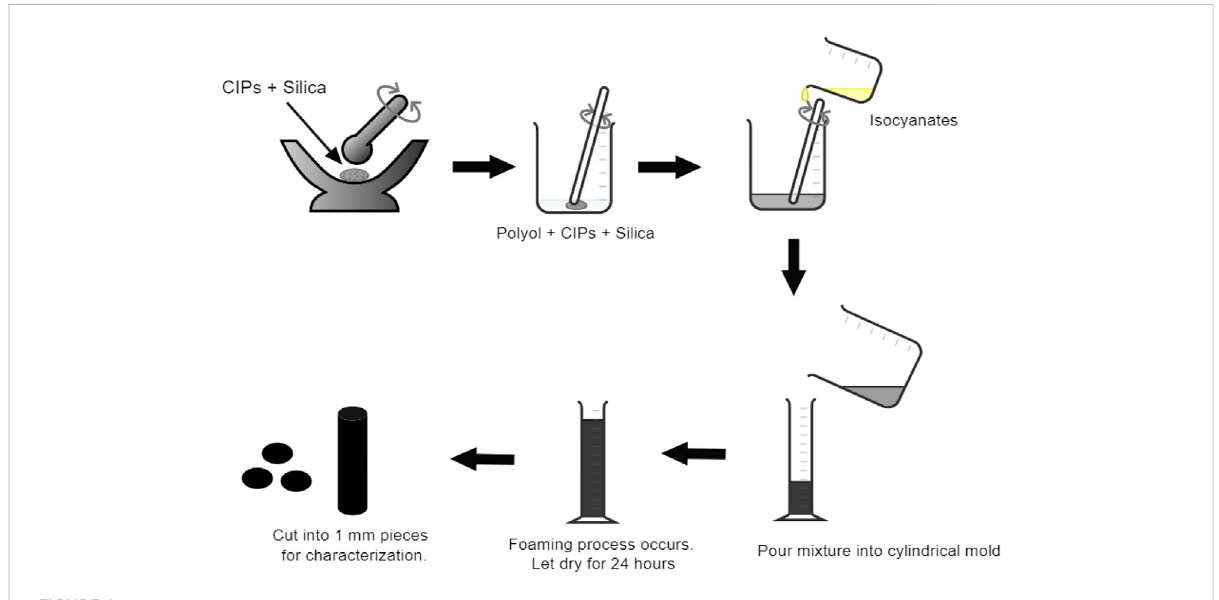
FIGURE 1 The synthesis process of MR foam with the addition of silica